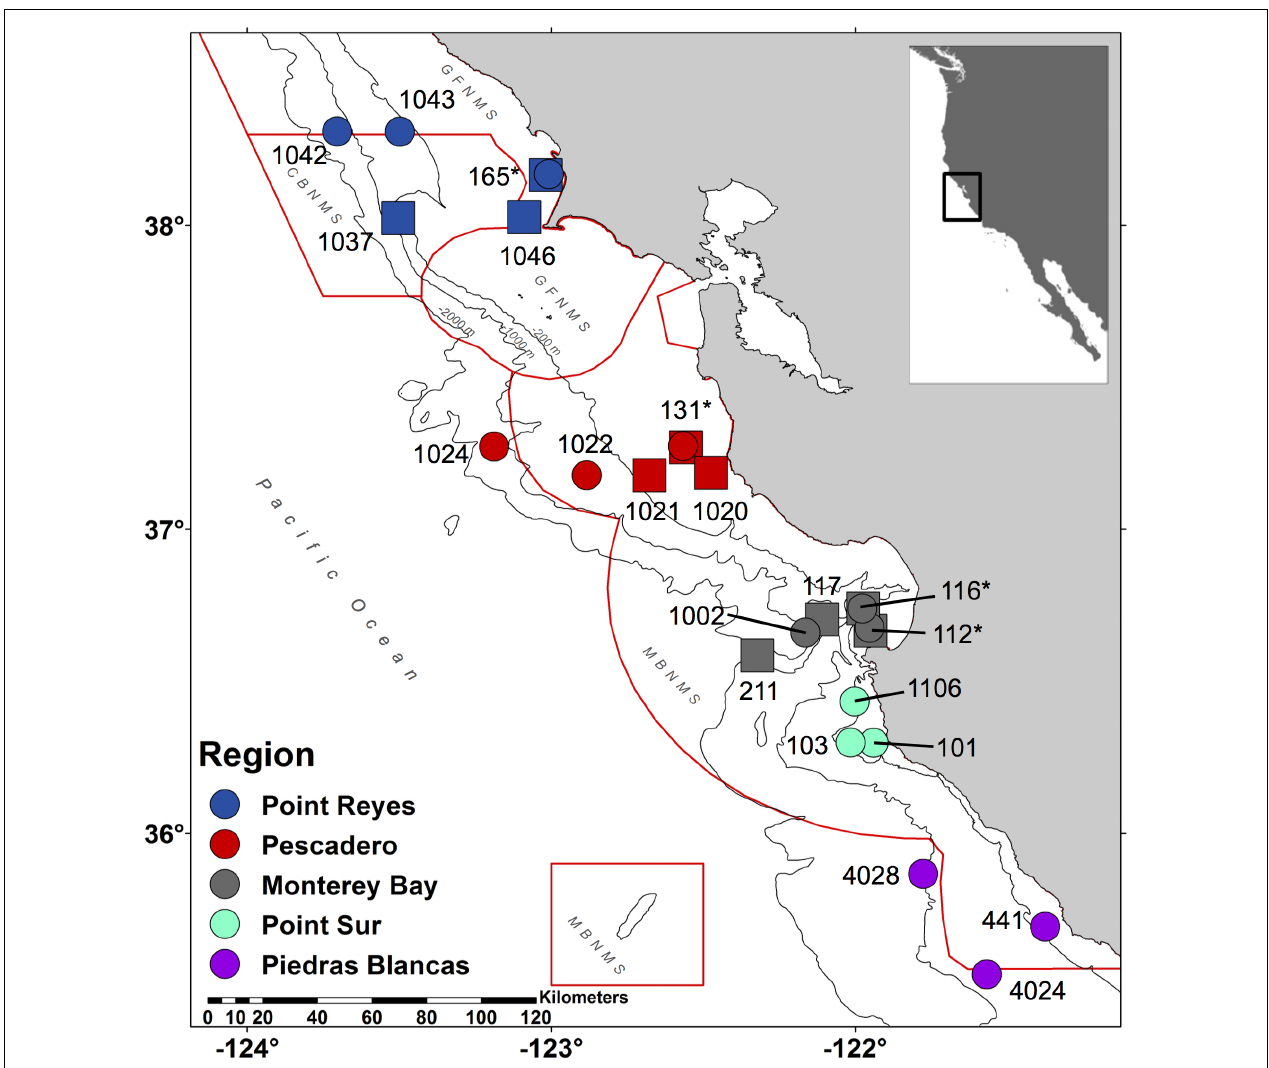
FIGURE 1 | Central California eDNA sampling map. This map indicates the stations where seawater was collected during 2016 (circles) and 2017 (squares). Each location, from north to south, is indicated by a color: Point Reyes (blue), Pescadero (red), Monterey Bay (gray), Point Sur (turquoise), and Piedras Blancas (violet). National Marine Sanctuaries are outlined in red from north to south: Gulf of the Farallones (GFNMS), Cordell Bank (CBNMS), GFNMS again, and Monterey Bay (MBNMS) with an additional red box around Davidson Seamount, which is part of MBNMS. Contours are 200, 1000, and 2000 m isobaths. Stations that were collected both years = ∗